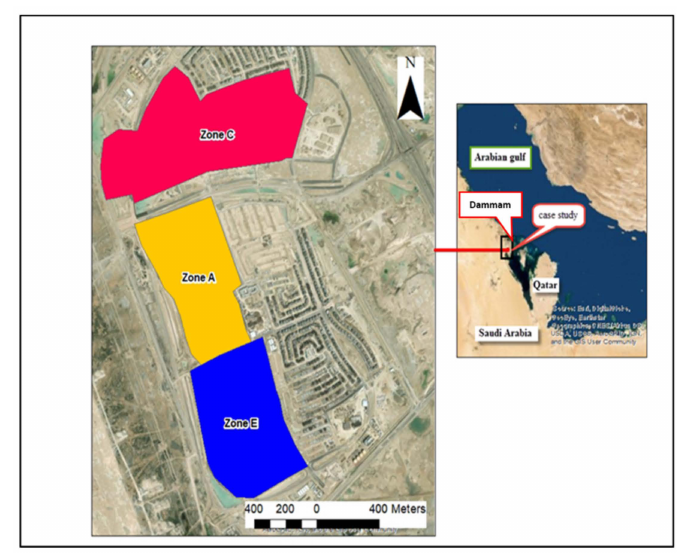
Figure 1. Location map of the study